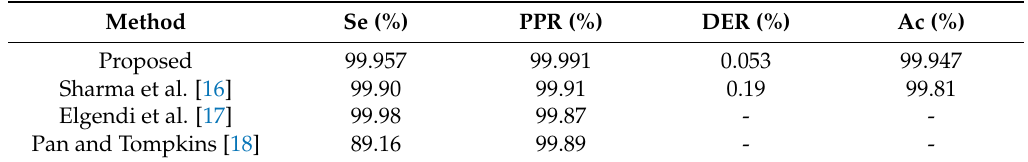
Table 6. Performance comparison with the Fantasia